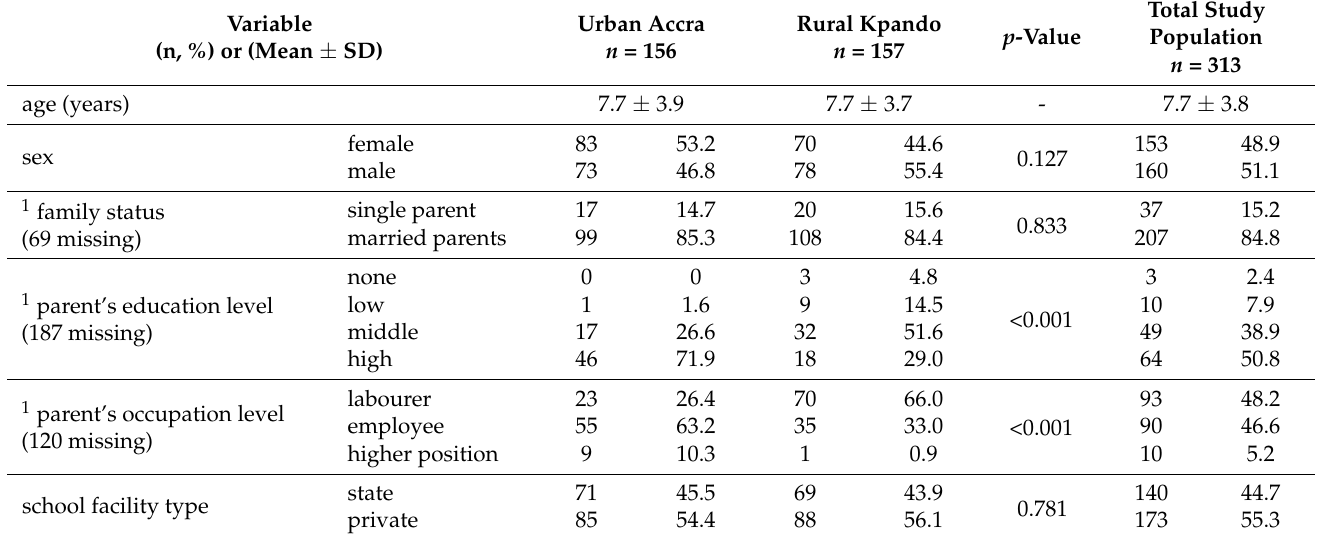
Table 1. Socio-demographic determinants of the study